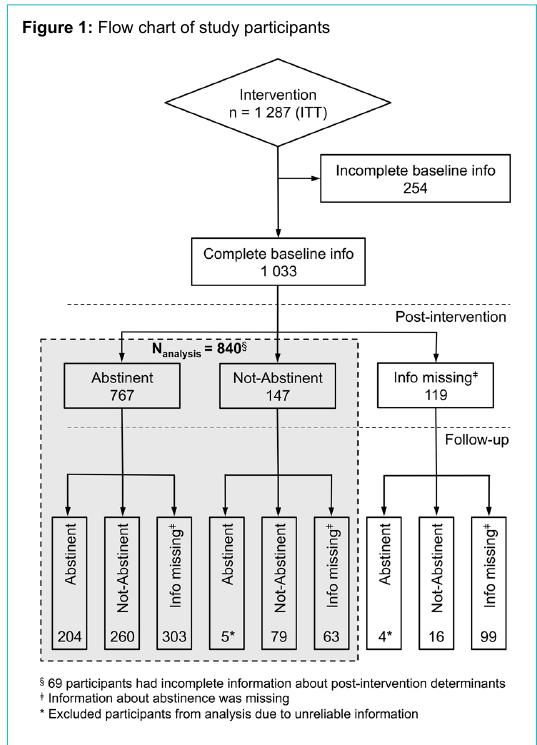
Figure 1: Flow chart of study participants